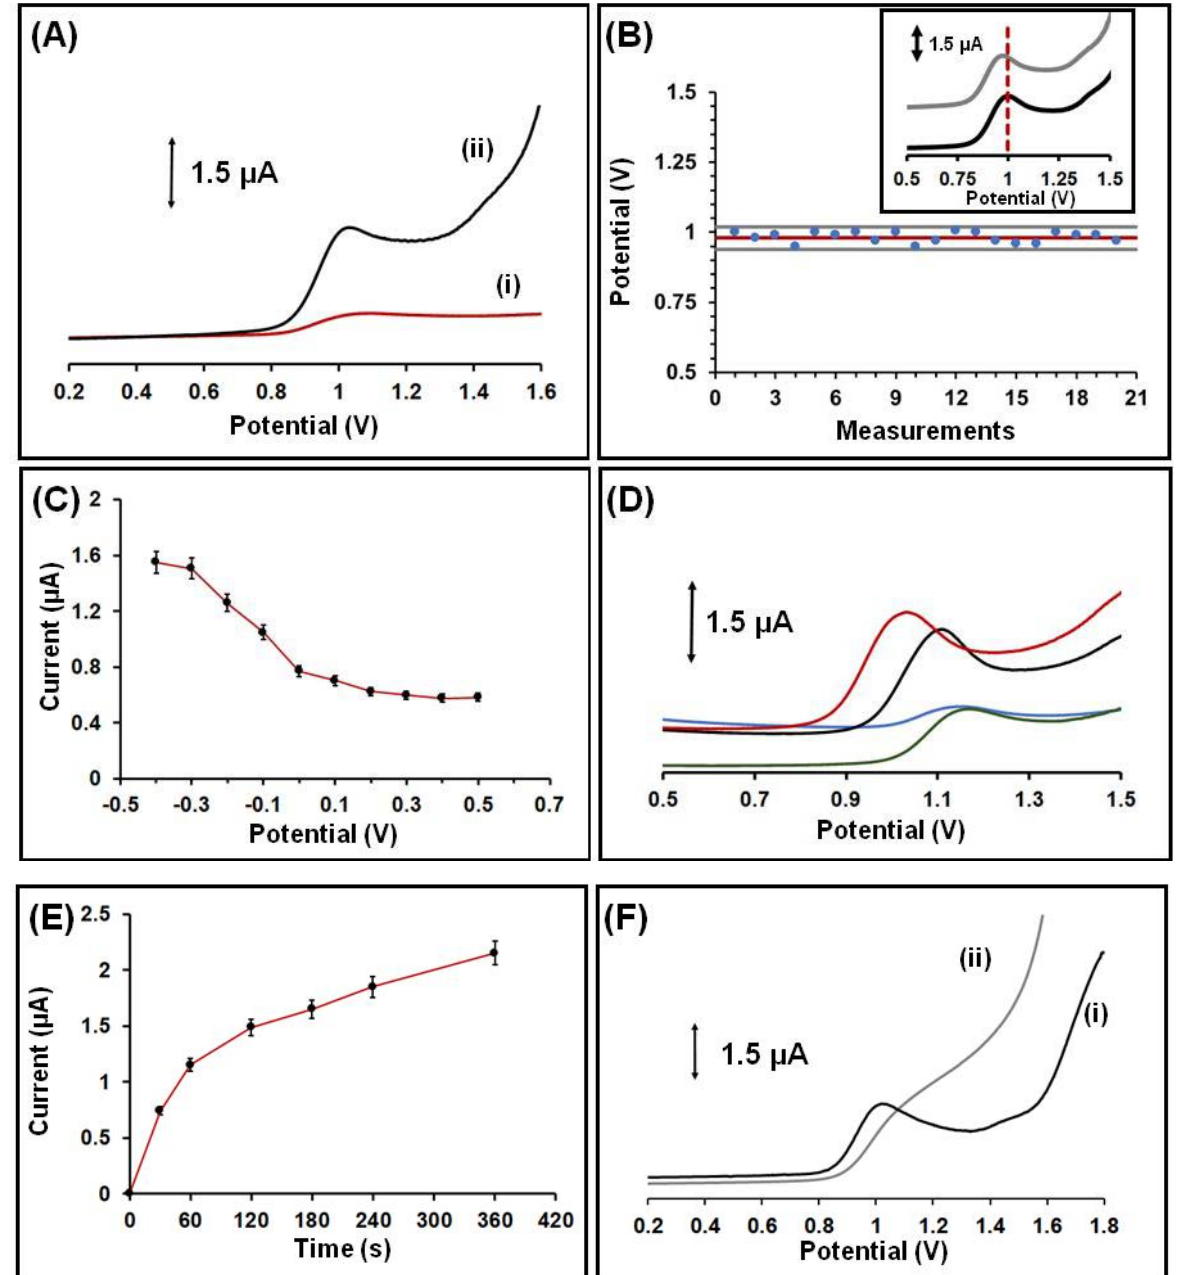
Figure 2. ( A ) CV responses of the 3D-printed device in the presence of 50 × 10 − 7 mol × L − 1 (red line) and 200 × 10 − 7 mol × L − 1 QF. Scan rate: scan rate, 50 mV × s − 1 ; electrolyte, 0.1 mol × L − 1 acetate buffer (pH 4.8). ( B ) Possible reaction of QF on the carbon black-loaded PLA WE.